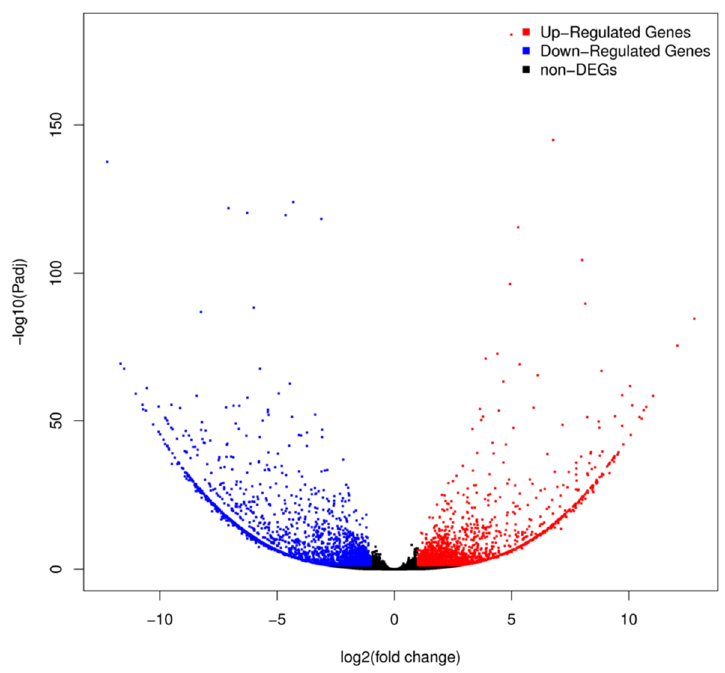
Figure 4. Differentially expressed genes between the 2766-KO strain and WHS train. X-axis shows the log 2 (fold change), and Y-axis shows the − log 10 ( p -values). The higher the value is on the Y-axis, the lower the corresponding adjusted p -value is. All dots represent a fold change ≥ 2 and p -value ≤ 0.001. Red dots indicate upregulated DEGs. Blue dots indicate downregulated DEGs. Black dots indicate non-regulated genes.